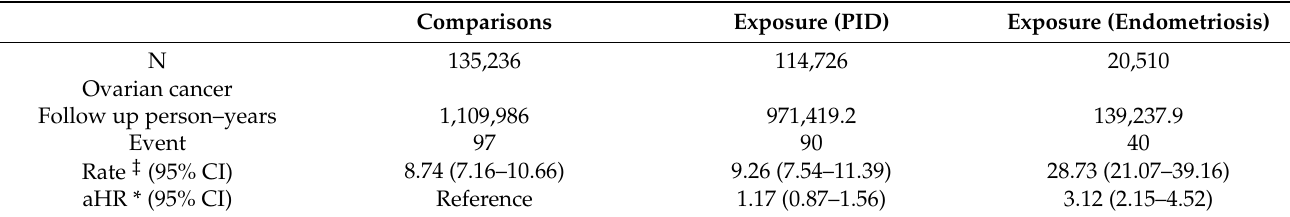
Table 2. Incidence rate and risk of ovarian cancer before PSM (age and birth year matched between exposure (PID/endometriosis) and comparison cohorts).